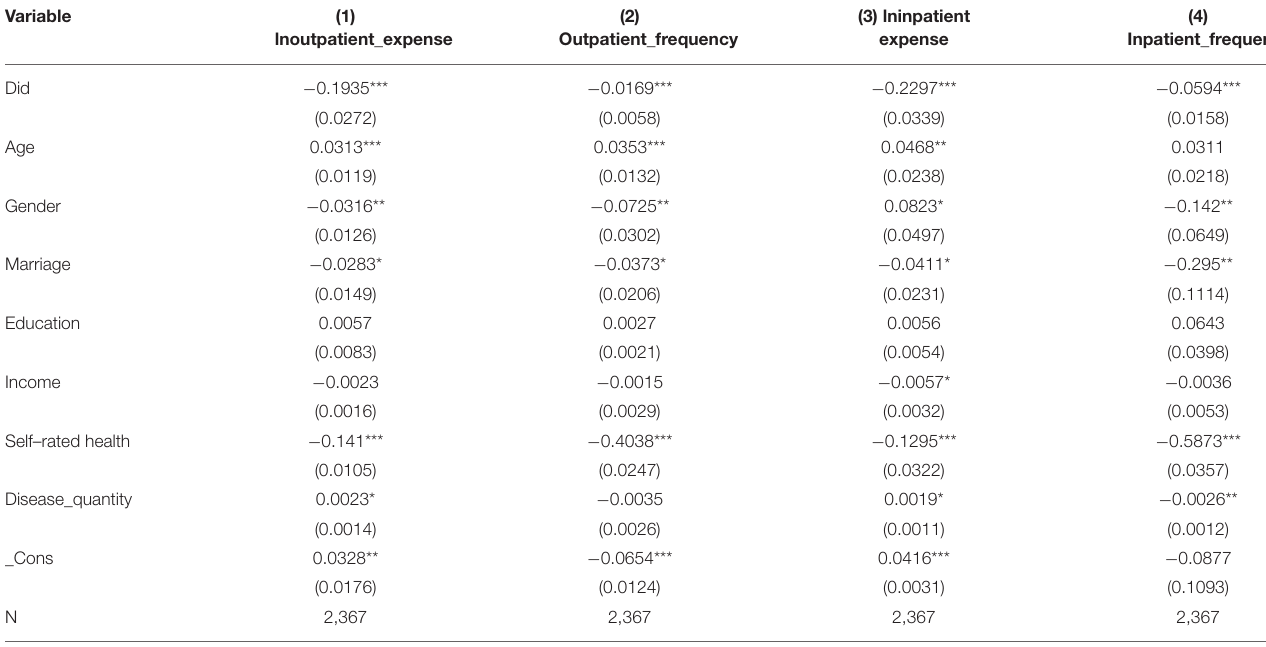
TABLE 6 | DID results with the second trial tier 11 cities as the control group.